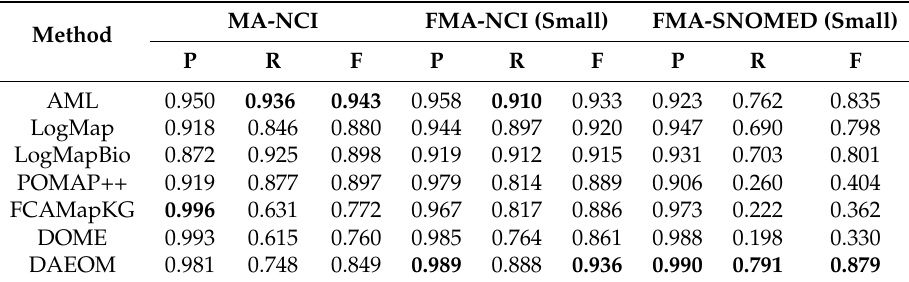
Table 3. The comparison of DAEOM with OAEI 2019 top-ranked systems.